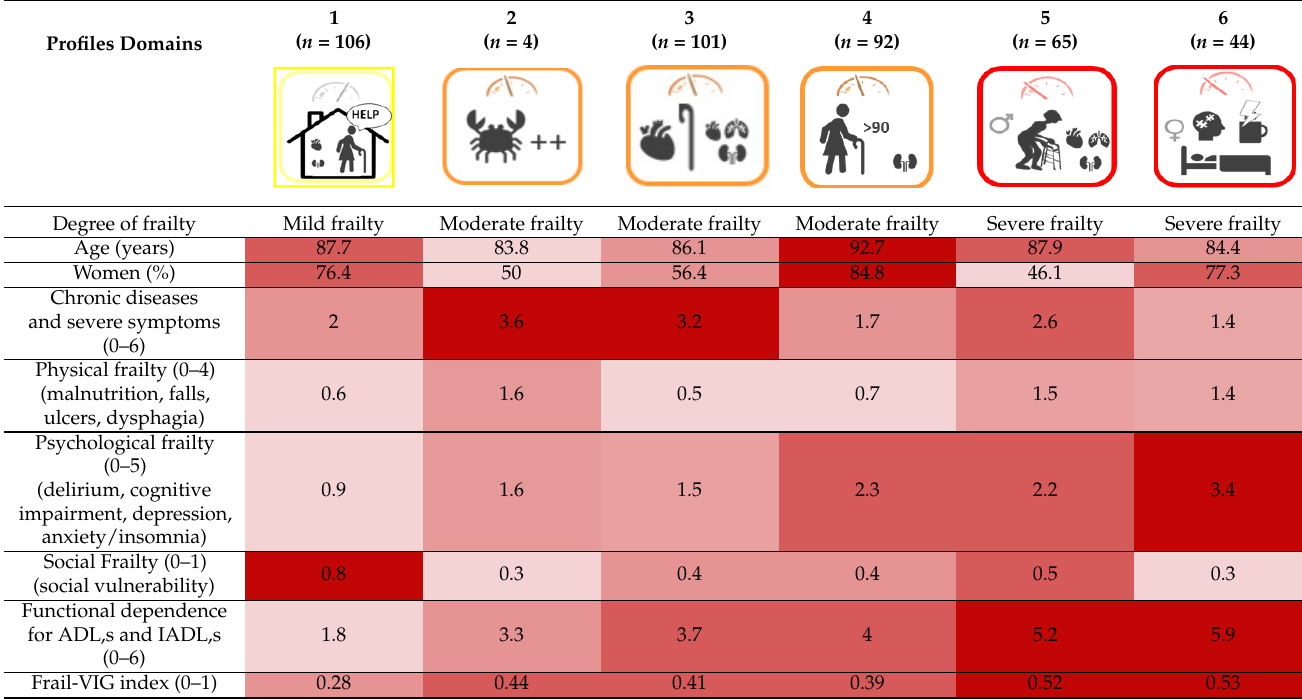
Table 2. Summary of the variables used to define each of the six frailty profiles in the cluster analysis.